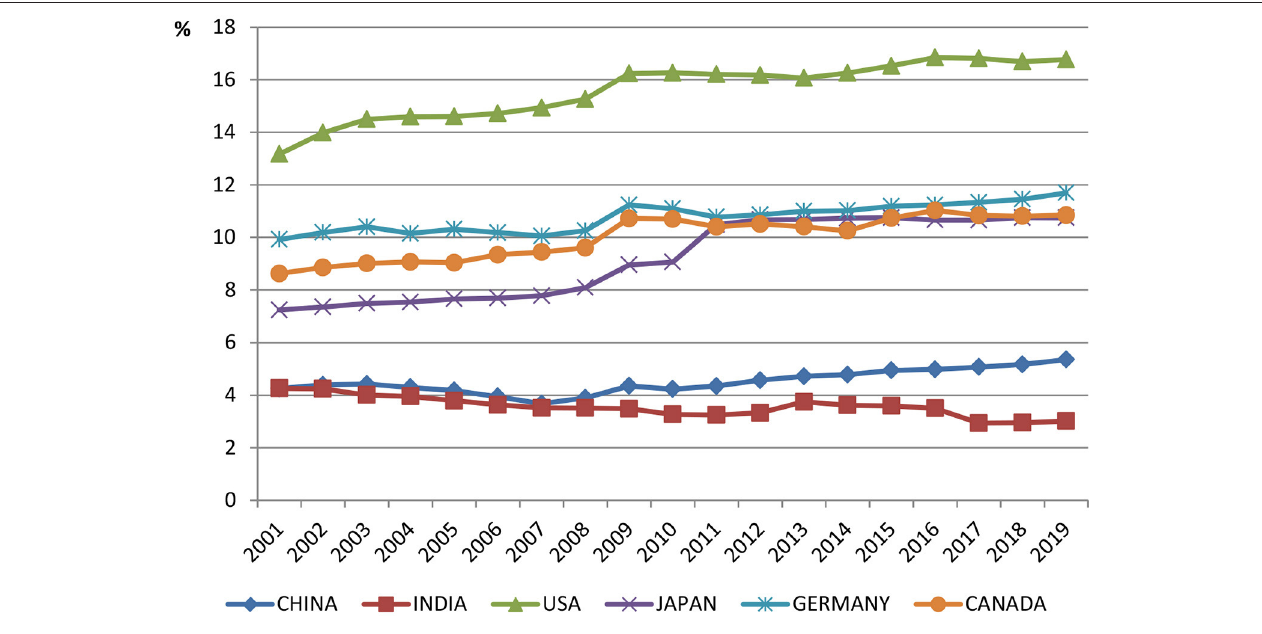
FIGURE 1 | Current health expenditure (% of GDP) of some countries in the